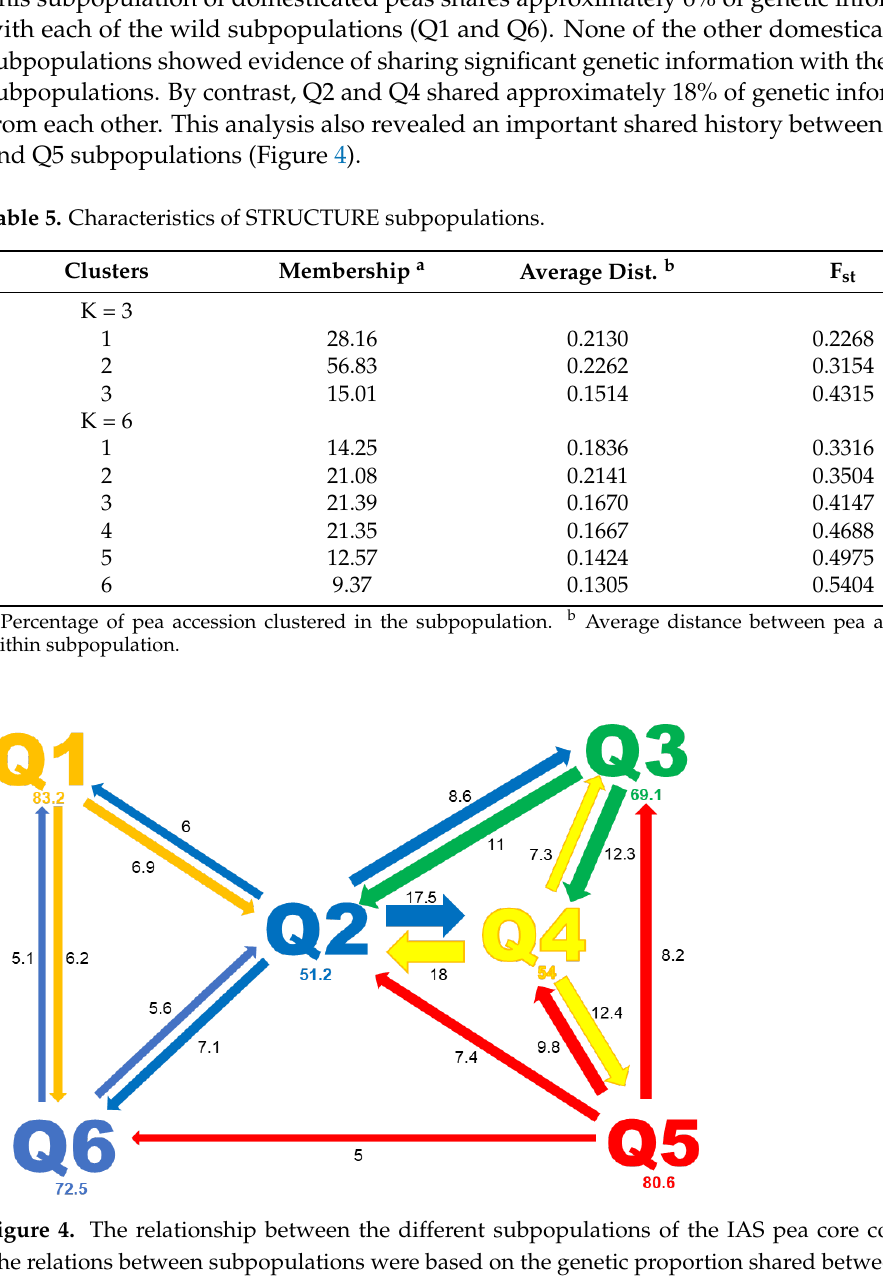
Figure 4. The relationship between the different subpopulations of the IAS pea core collection. The relations between subpopulations were based on the genetic proportion shared between them, as estimated by STRUCTURE. The arrow indicates the donor and receiver subpopulations. The num- numbers indicate the mean proportion of membership (in %) given by the donor bers indicate the mean proportion of membership (in %) given by the donor subpopulation. Only contributions of at least 5% are presented .